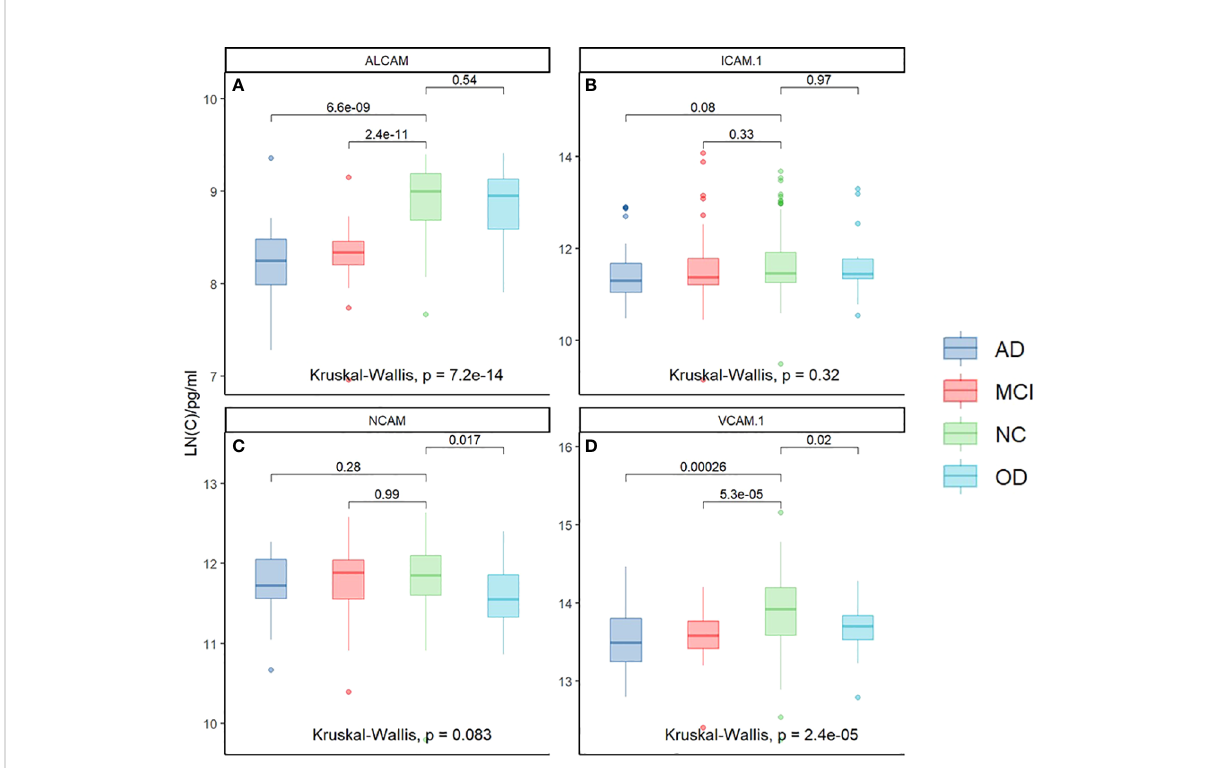
FIGURE 1 The relationship of Plasma CAMs in different groups: ALCAM (Kruskal-Wallis test, p<0.001) and VCAM-1 (Kruskal-Wallis test, p<0.001) demonstrated signi fi cant differences among the four groups. Plasma ALCAM was different between NC and AD (p<0.001), and between MCI and AD (p<0.001). (A) There were no signi fi cant differences in ALCAM between AD and OD. (B) There was no signi fi cant difference in the plasma ICAM-1 between the two groups. (C) Patients with AD had a higher level of NCAM than OD (p<0.05) but not MCI or NC. (D) A higher level of VCAM-1 was reported in the plasma of AD patients than in MCI (p<0.001), NC (p<0.001), and OD (p<0.05). *Y-axis represents the natural logarithm (LN) of CAM